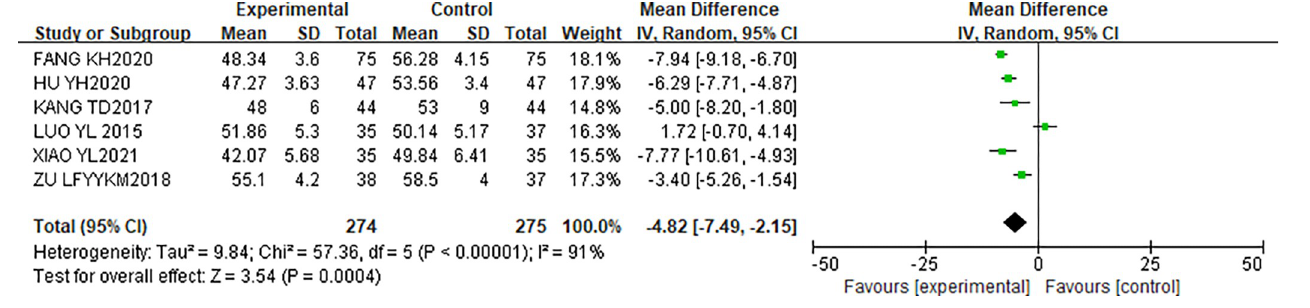
Fig 5. Influence of CR on LVEDD of